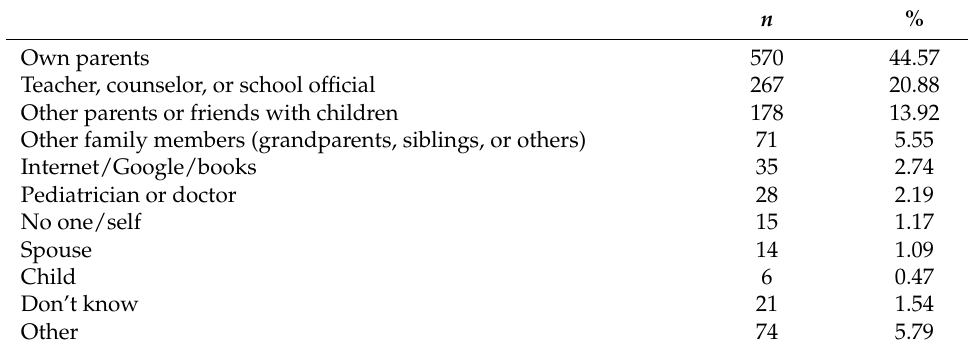
Table 5. Responses to “Imagine you are a parent of a four-year-old. You want to make sure she is ready to start kindergarten when she is five. Who do you ask for